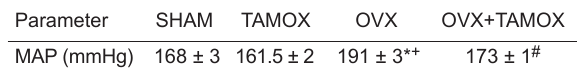
Table 1. Baseline values of blood pressure obtained from sponta- neously hypertensive female rats in the four treatment groups.